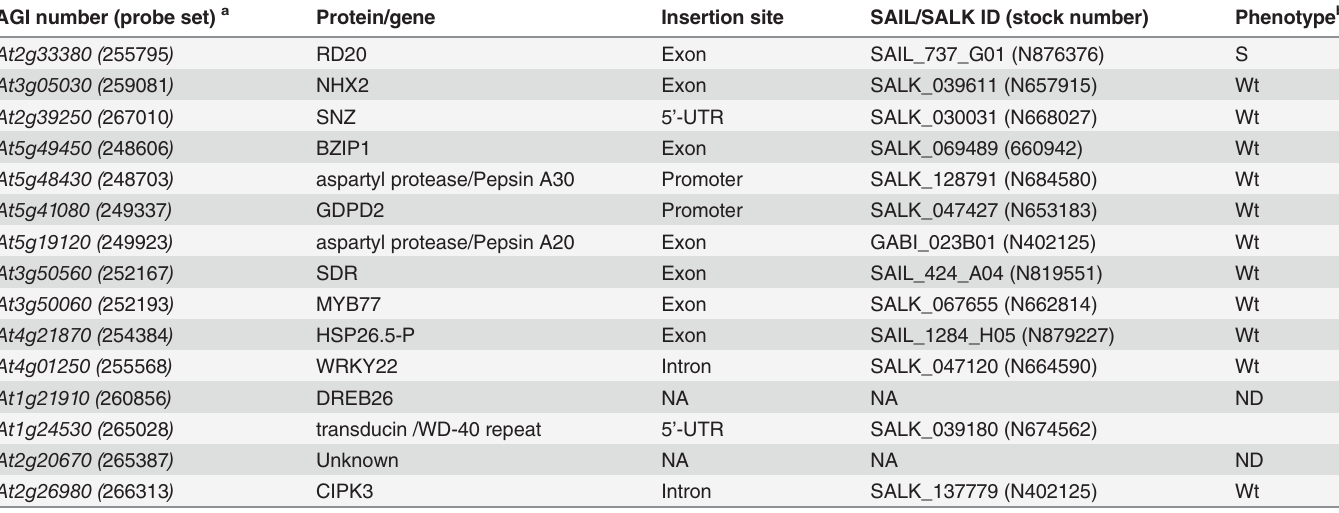
a Expression of common up-/down-regulated genes data were obtained from Table 2 of this study and [20]. b Wt, disease response comparable to wild-type plants; S, susceptible. SAIL_737_G01 plants show increased local susceptibility to B . cinerea (Fig 4). T-DNA insertion mutants were assayed for their disease responses at least three